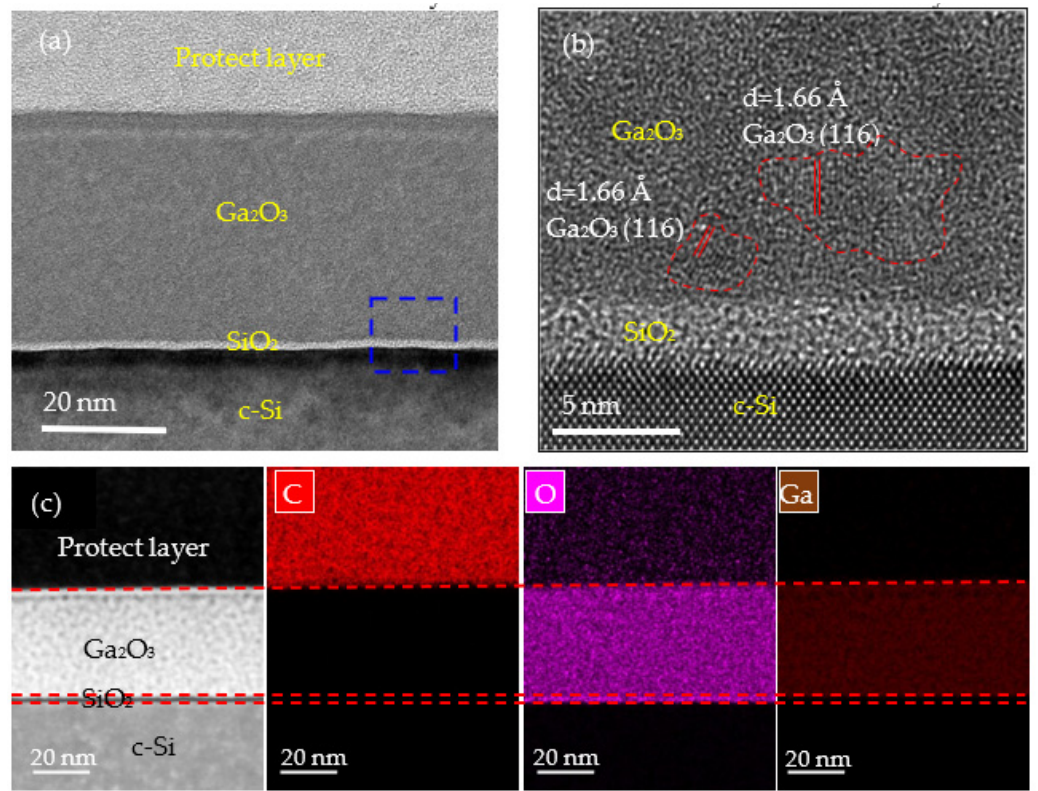
Figure 5. Cross-sectional HR-S/TEM images of a PEALD Ga 2 O 3 film deposited at 250 °C at magnifi- cations of ( a ) 245 k and ( b ) 1050 k. The areas marked by red lines indicate the nanocrystalline struc- ture. ( c ) EDX elemental mapping for the as-deposited Ga 2 O 3 film.